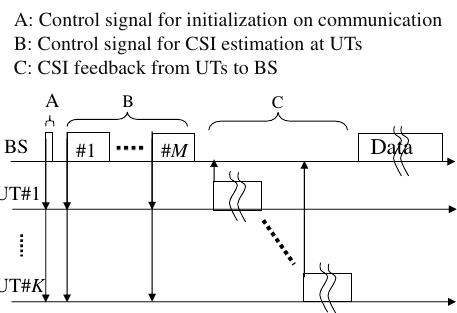
Figure 1. Frame format for multi-user multiple-input multiple-output (MU-MIMO) transmission with channel state information (CSI)